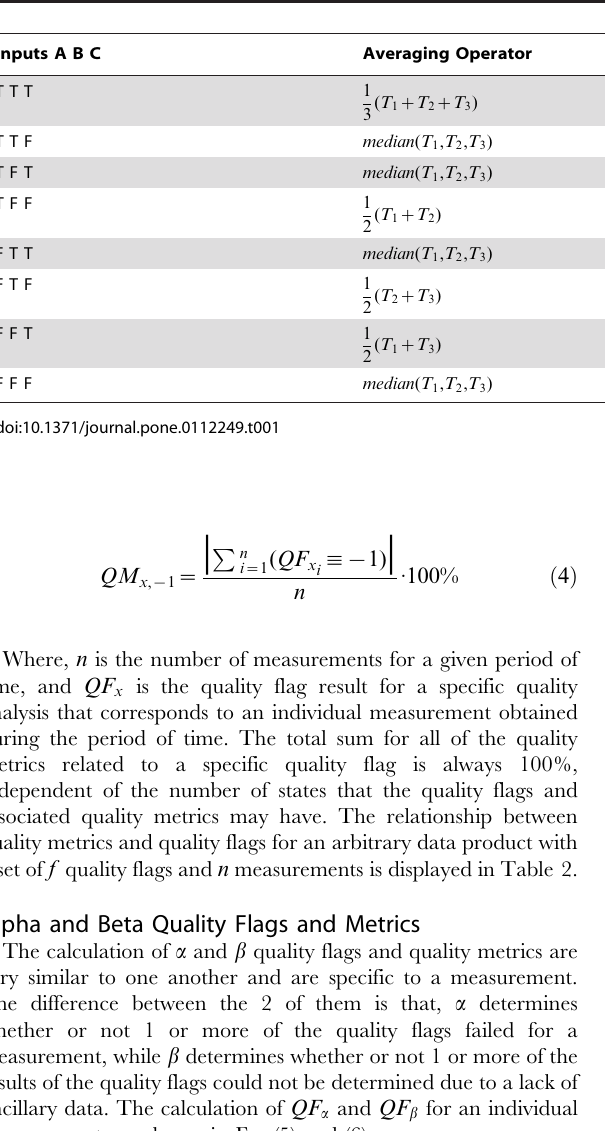
Table 1. Treatment of temperature sensor data based on results from pair-wise comparisons, i.e., Eq. (9)–(11).